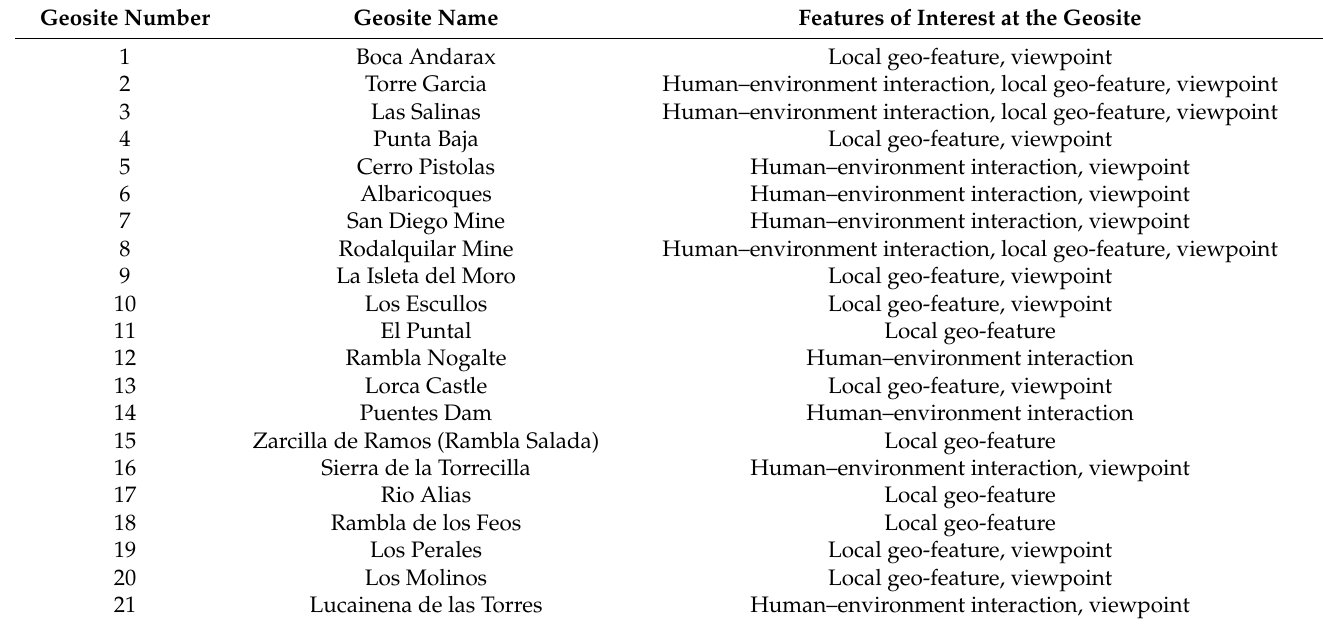
Table A2. Grouping of the 34 geosites into 5 clusters based on features of interest (see the methodology section to understand how the classification was